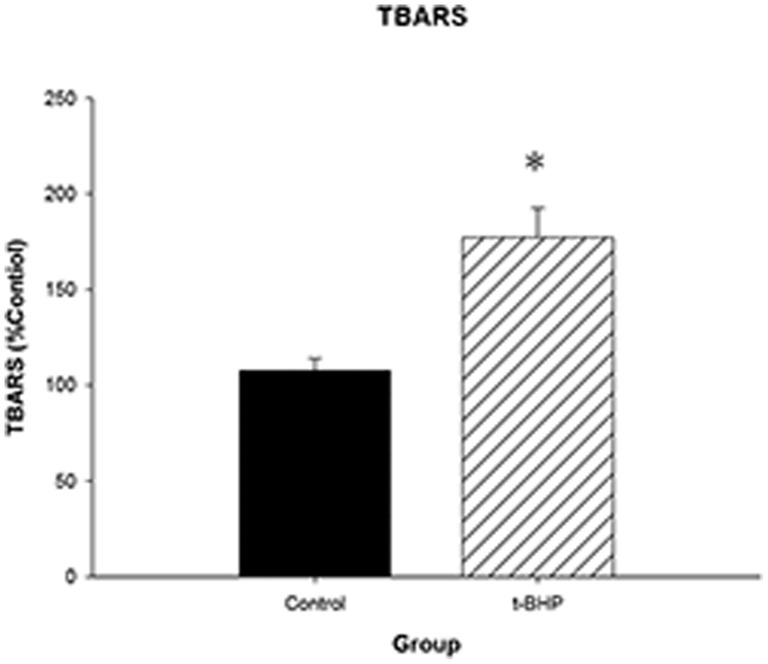
Intracellular oxidative fatty acid content analysis.Cells were collected, treated with trichloroacetic acid/TBARS reagent and incubated at 95°C for 60 min. The supernatants were analyzed, and the values are expressed as percentage of control values. The data are expressed as the means±S.D. (n = 6). * indicates a comparison with the blank control group (p<0.05).